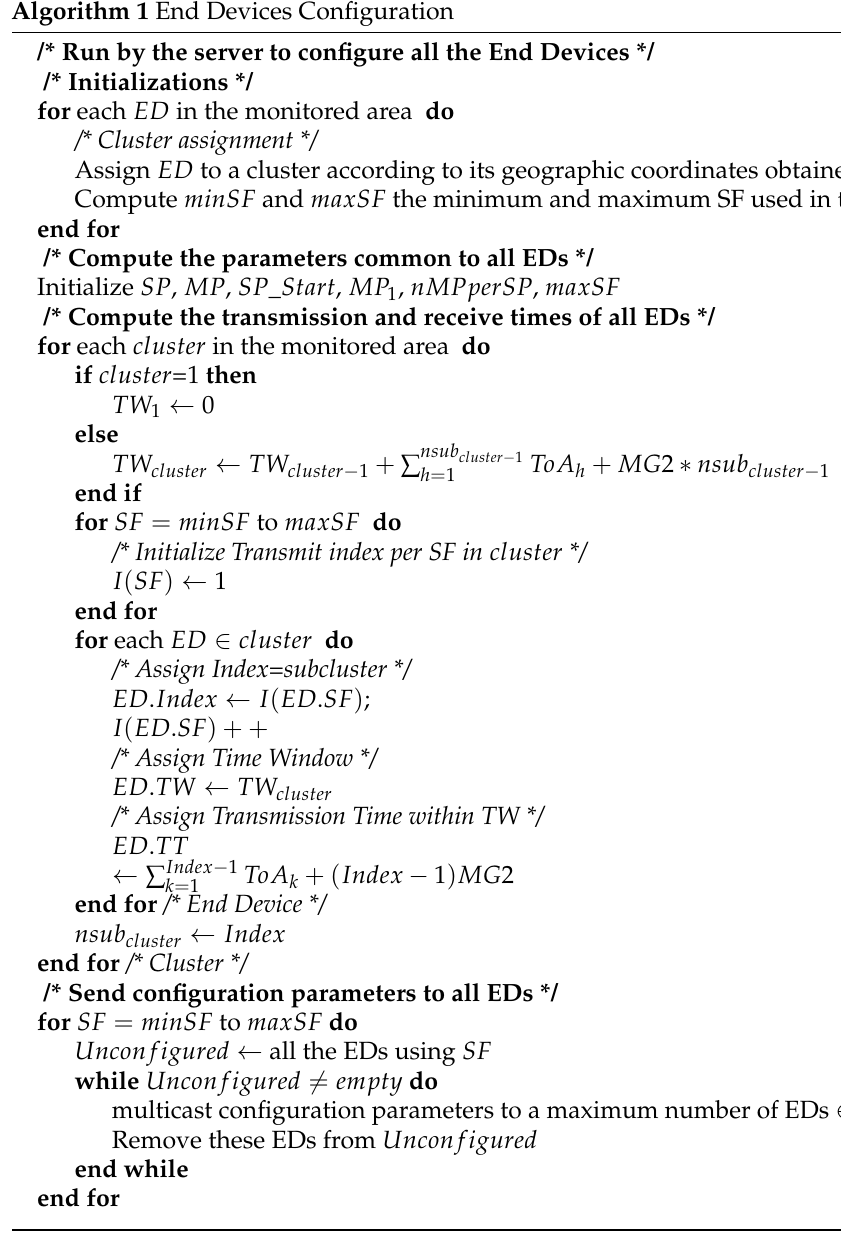
Algorithm 1 End Devices